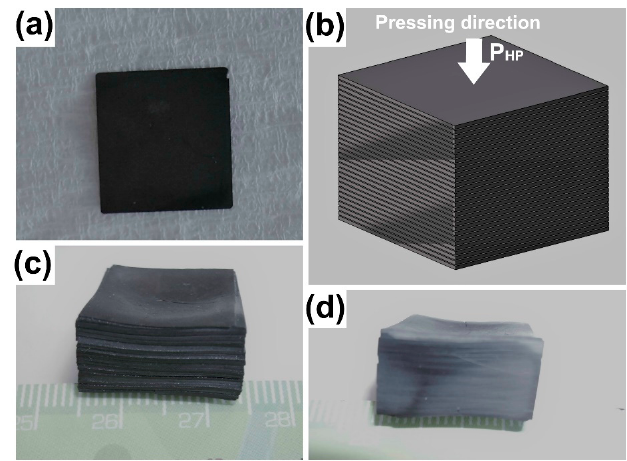
Figure 2. Fabrication of thick Ca 3 Co 4 O 9 ceramics using the hot pressing (HP) process. ( a ) HP-textured single sample cut into ~18 × 18 × 0.5 mm 3 parallelepiped form and mirror-polished. ( b ) Schematic of a batch of single HP samples stacked along their mean c*-axis. ( c ) A ~9 mm-thick sample obtained upon the treatment of the HP stack at 1193 K under a moderate uniaxial pressure of 10 MPa for 10 h. ( d ) Cross-section view upon cutting the HP stack in the direction parallel to the pressing axis.